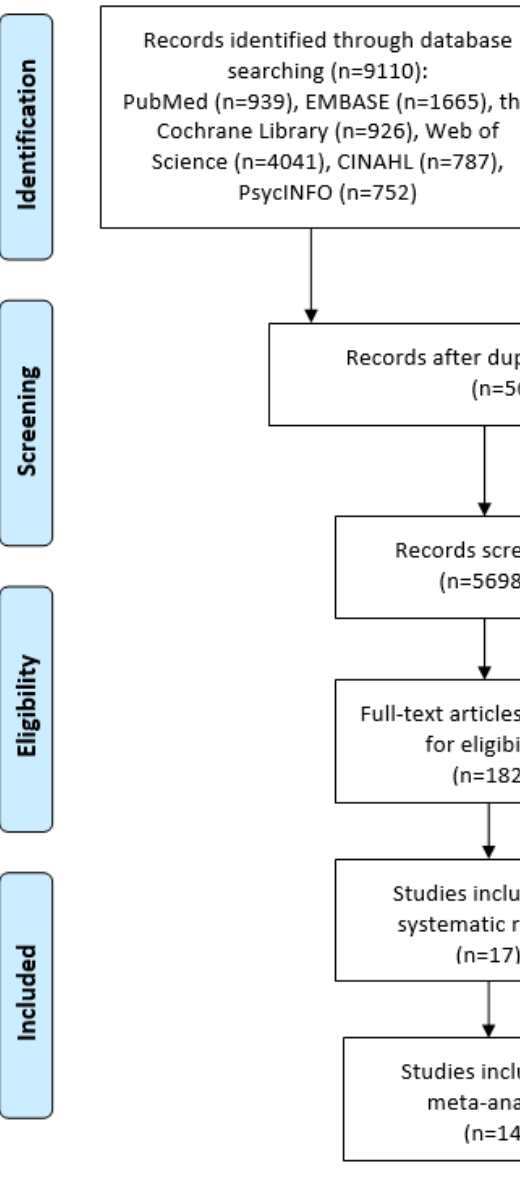
Figure 1. Flow diagram for search and selection of the included